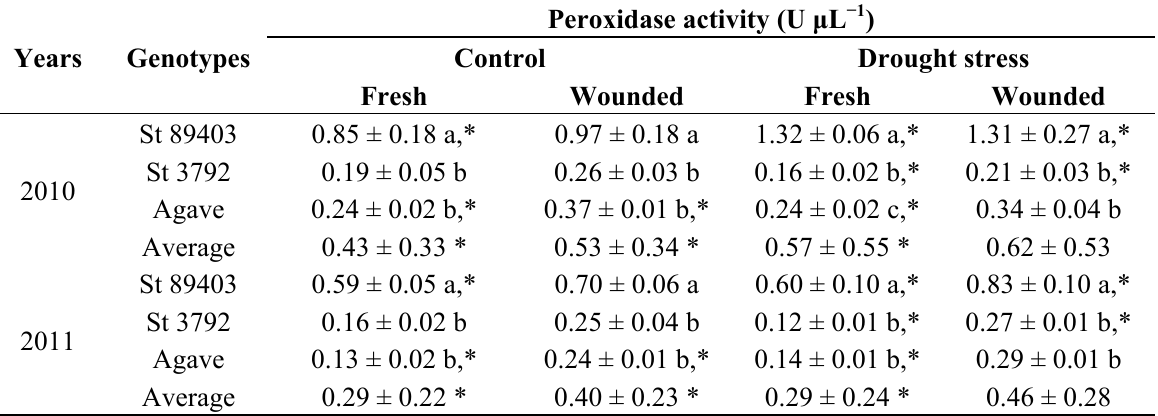
Table 4. Peroxidase activity in fresh tissue and 24 h after wounding of the control and drought stressed tubers grown in 2010 and 2011 (Mean ± SD; n =